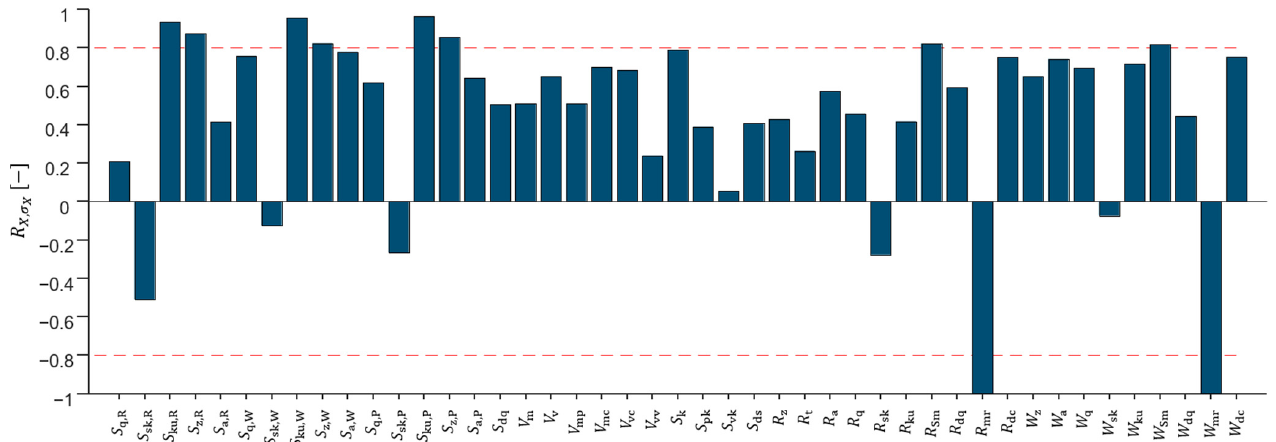
Figure 11. Correlation between mean value and standard deviation of surface properties.